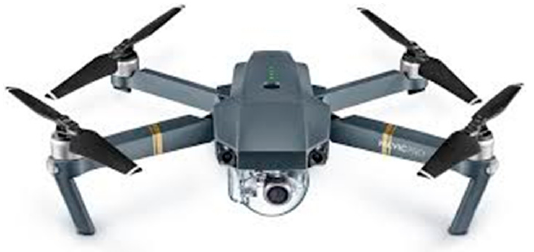
Figure 2. DJI Mavic 2 Pro: the unmanned aerial system used in the current study.